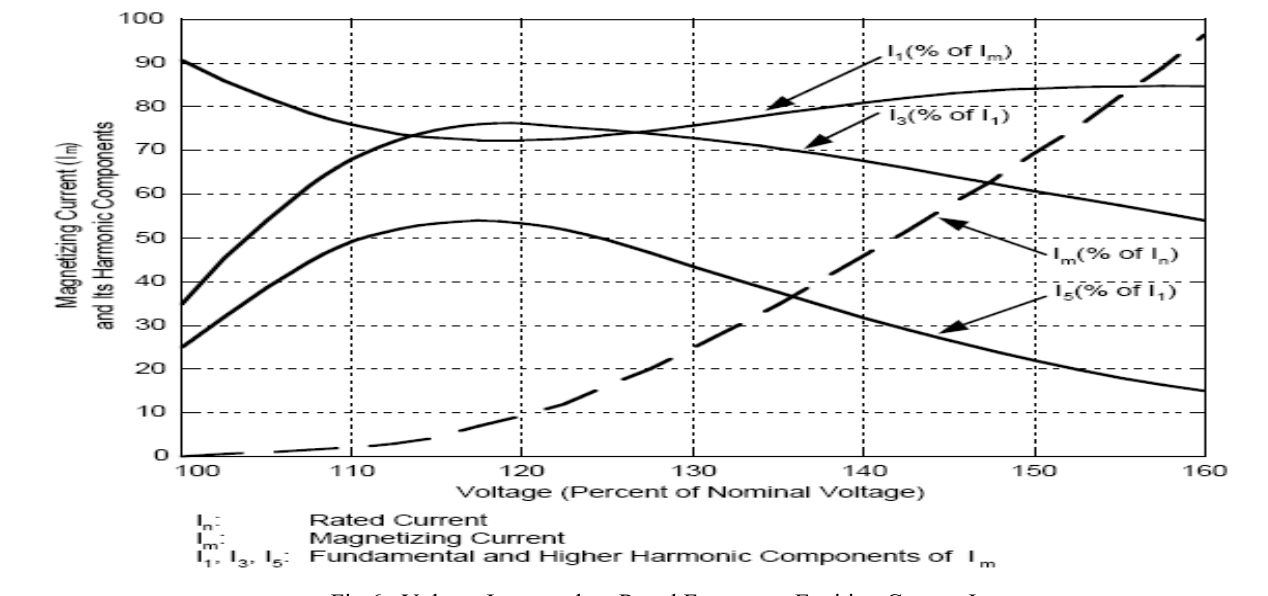
Fig 6. Voltage Increased, at Rated Frequency Exciting Current Increase